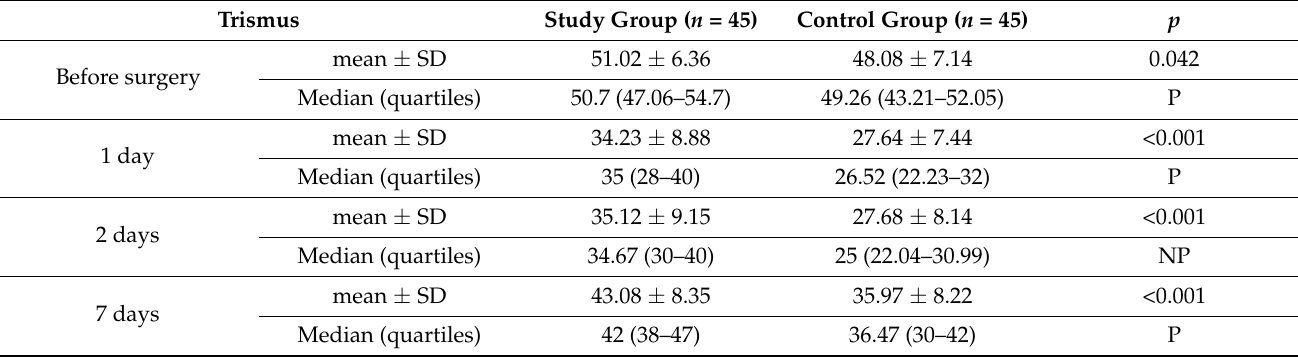
Table 5. Comparison of jaw dilation before surgery and postoperative Days 1, 2, and 7 between the study and control